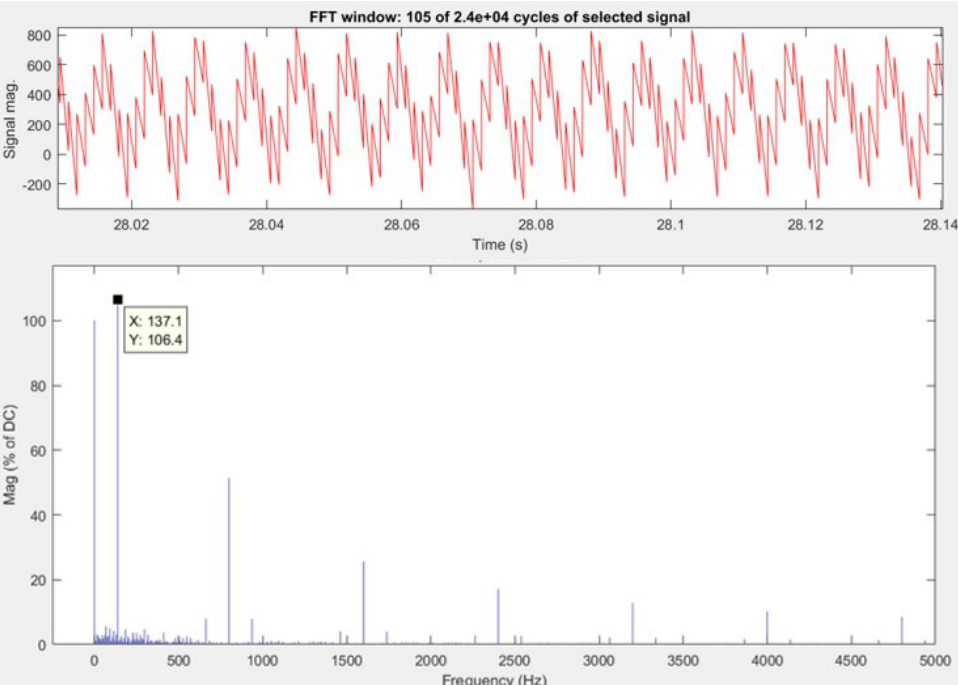
Figure 14. FFT analysis of the electromagnetic